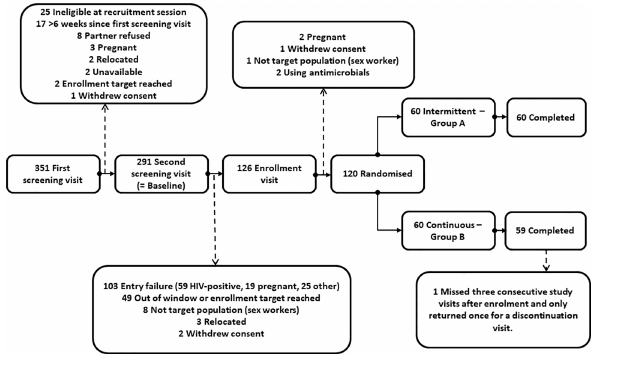
Fig 1. Participant